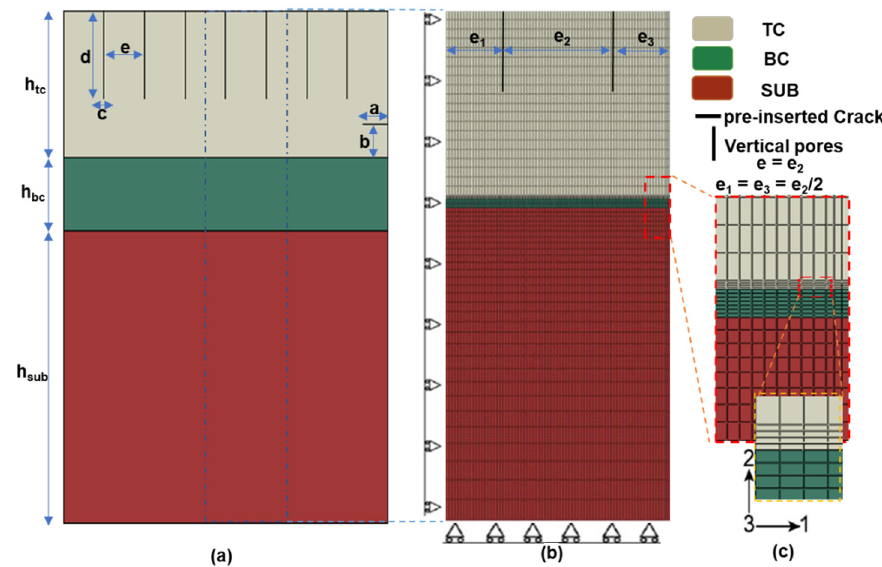
Figure 1. Model of TBCs with the TC crack close to the interface: ( a ) the physical geometry model; ( b ) FE mesh and boundary conditions; and ( c ) the refined meshes near the TC/BC interface.